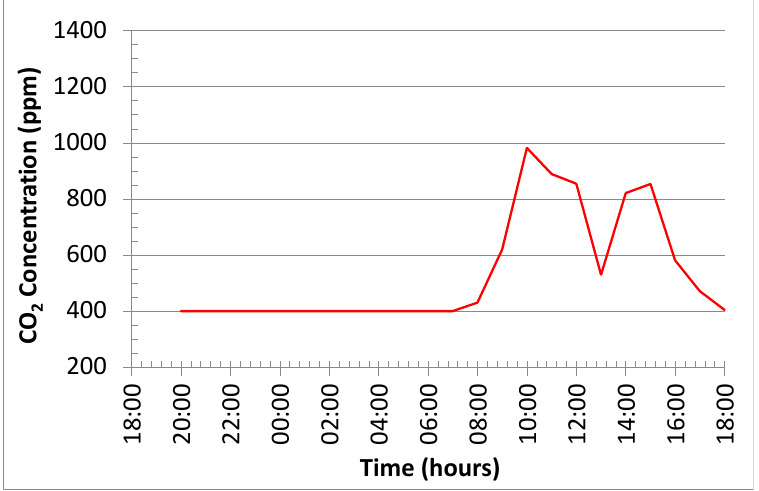
Figure 22. Simulated CO 2 concentration for the field experiment.